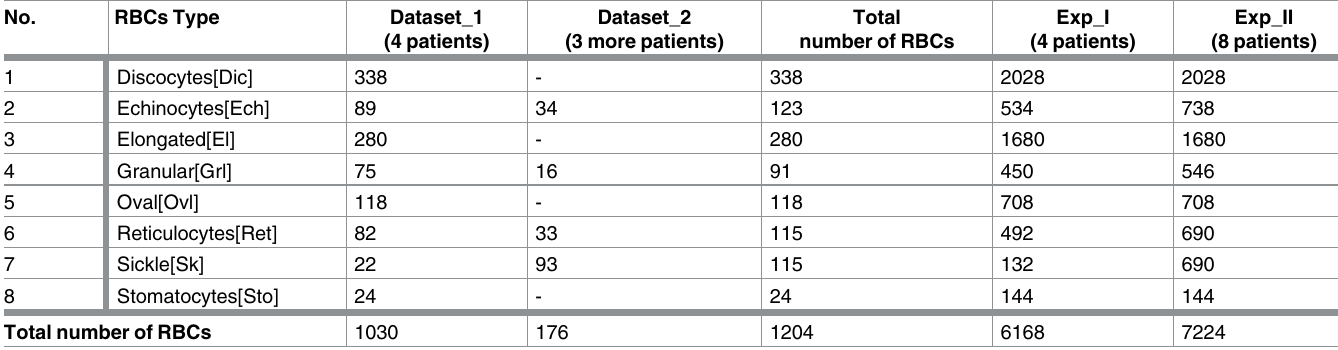
Table 1. Description of our experimental dataset from eight patients’ imaging data.